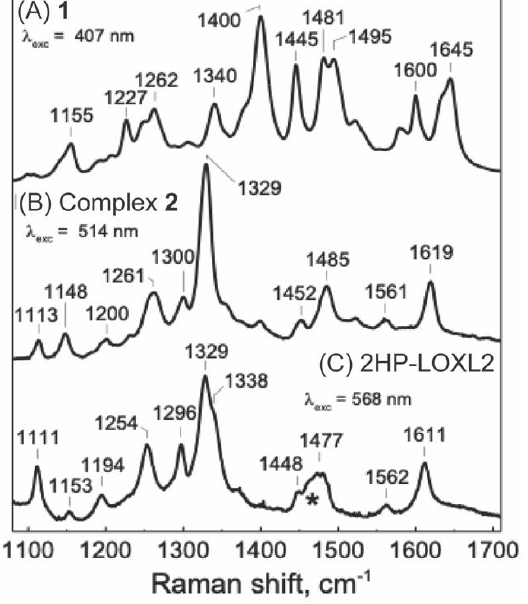
Figure 7. Room temperature RR spectra of 1 ( A ) and Complex 2 ( B ), and 2HP − inhibited LOXL2, 2HP − LOXL2 ( C ); the asterisk (*) denotes the Raman contribution of residual glycerol at 1470 cm − 1 .